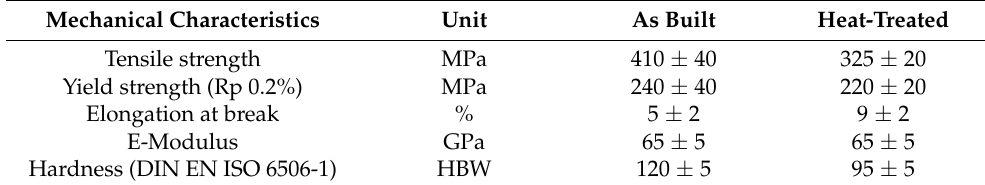
Table 5. AlSi10Mg mechanical properties.